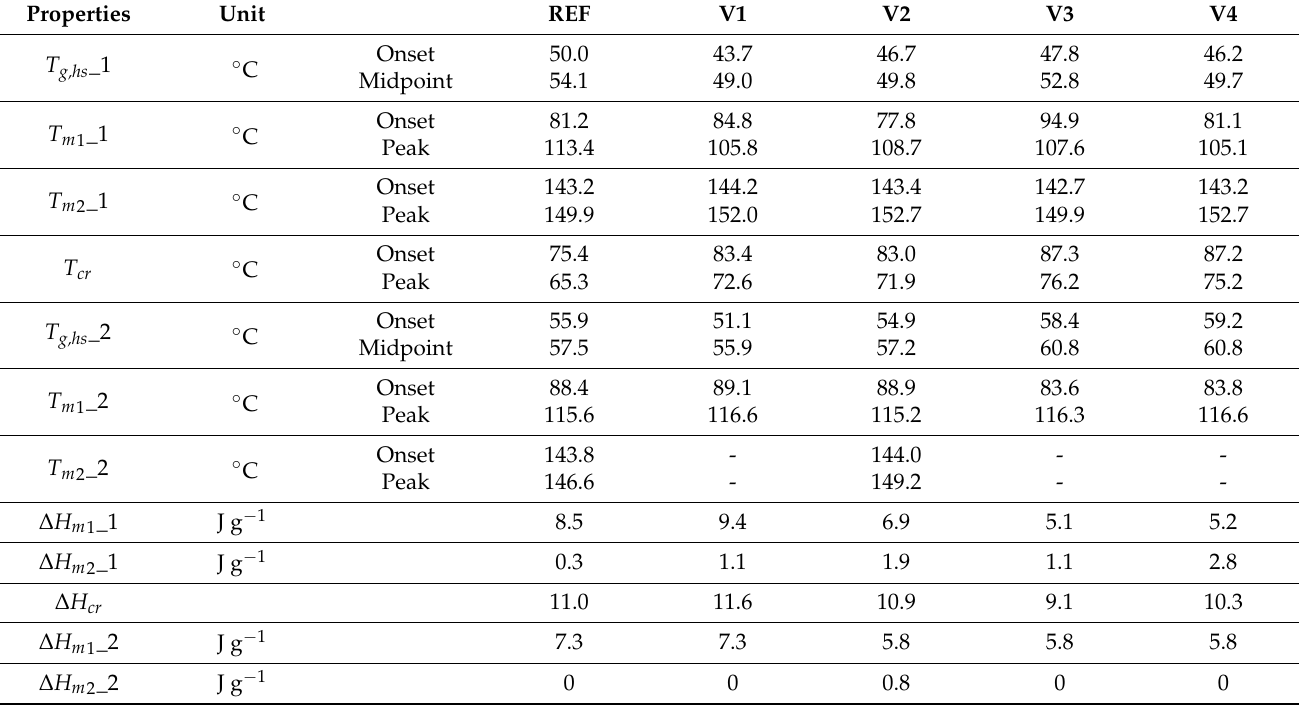
Table 3. The glass temperatures of hard segments T g,hs , crystallization temperature T cr , and melting temperatures T m 1 of PBAT and T m 2 of PLA with corresponding fusion heat values ∆ H m 1 and ∆ H m 2 , as determined in the first run, cooling run, and second run of the DSC measurements of granules of REF and V1 to V4